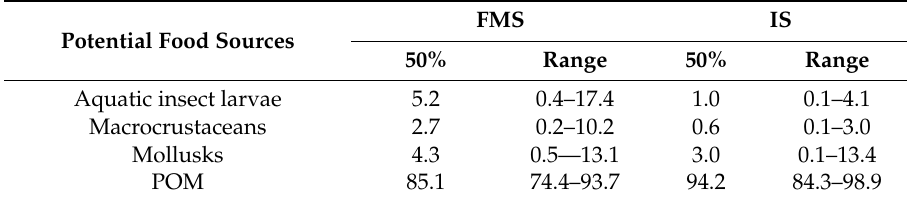
Table 5. Percentages of potential food contributions (50% quantiles, range = 95% Bayesian credible intervals) in two ontogenetic stages for Coreius guichenoti estimated using